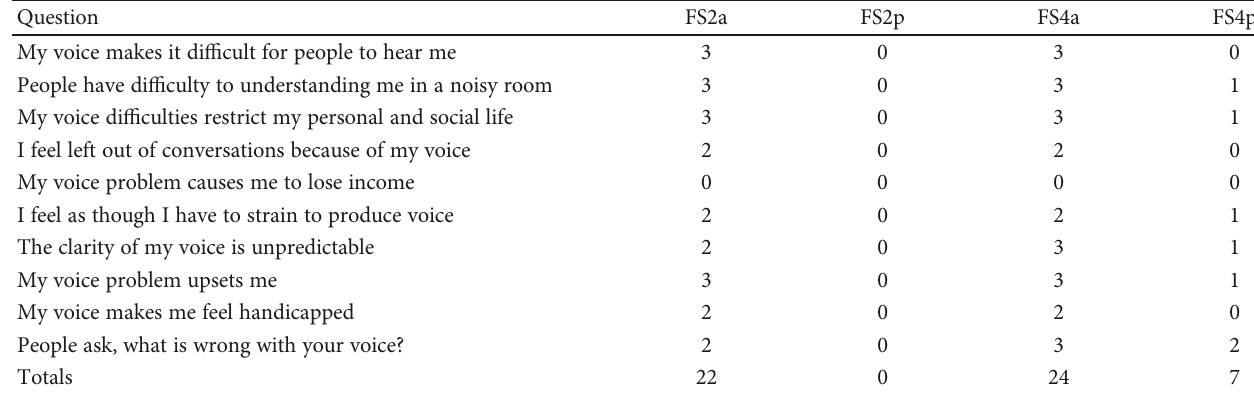
Table 9: VHI results for cases FS2 and FS4.